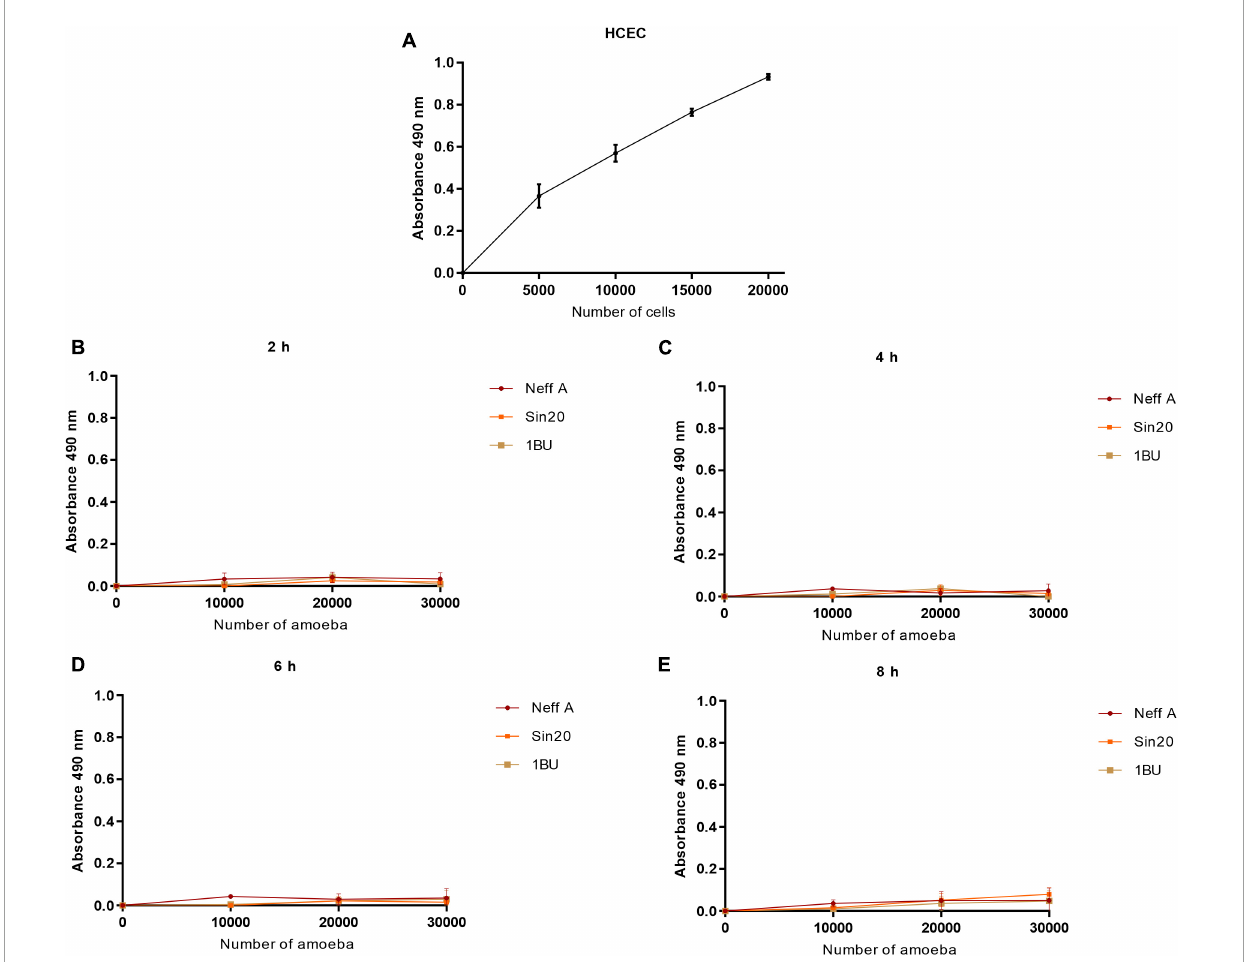
FIGURE3 Effect of HCEC (A) and amoeba (B–E) densities on absorbance at 490 nm by using the MTS assay, at different times. The background absorbance obtained with the media alone without cells was subtracted from all